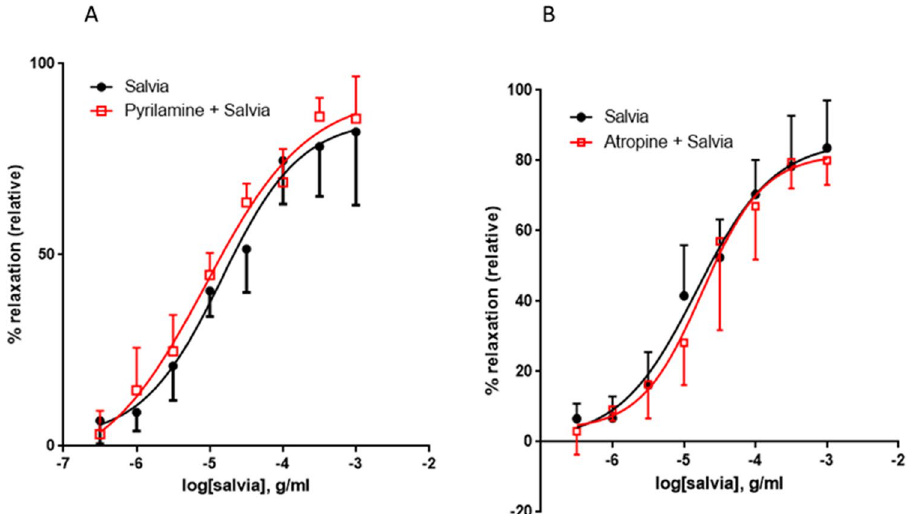
Figure 10. Involvement of histaminergic or muscarinic receptors in SF-induced vasorelaxation. Endothelium- intact rings were exposed to cumulative doses of SF in the absence (Salvia; circles) or presence of ( A ) 10 µ M of pyrilamine (pyrilamine + Salvia; squares), or ( B ) 10 µ M of atropine (atropine + Salvia; squares). Data represent mean ± SEM (n = 6 or 5 for pyrilamine or atropine experiments, respectively). p > 0.05 for Salvia alone versus either pyrilamine + Salvia or Salvia +